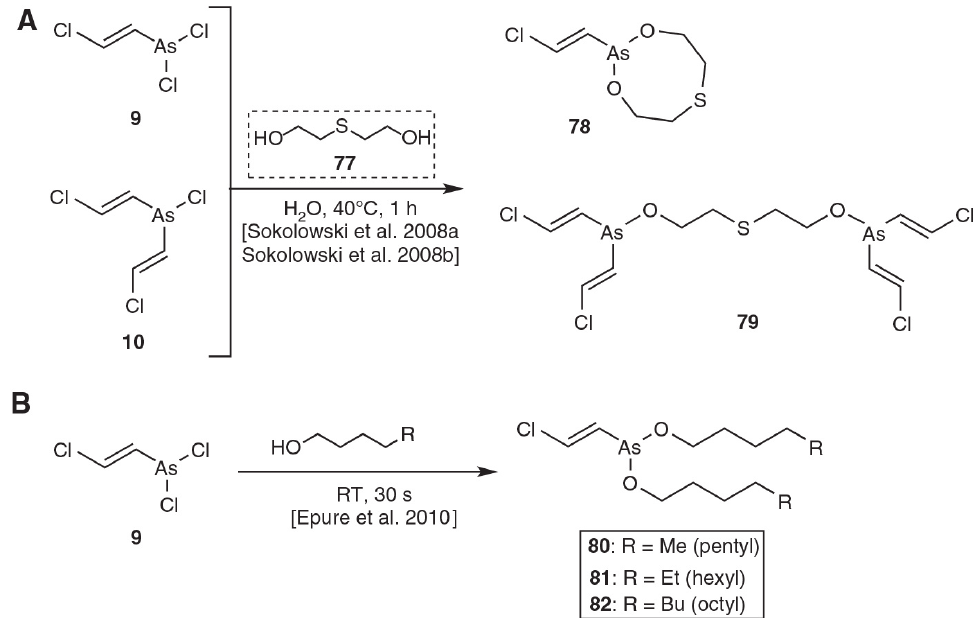
Figure 14: Use of alcohol-based derivatization agents for Lewisites I and II.